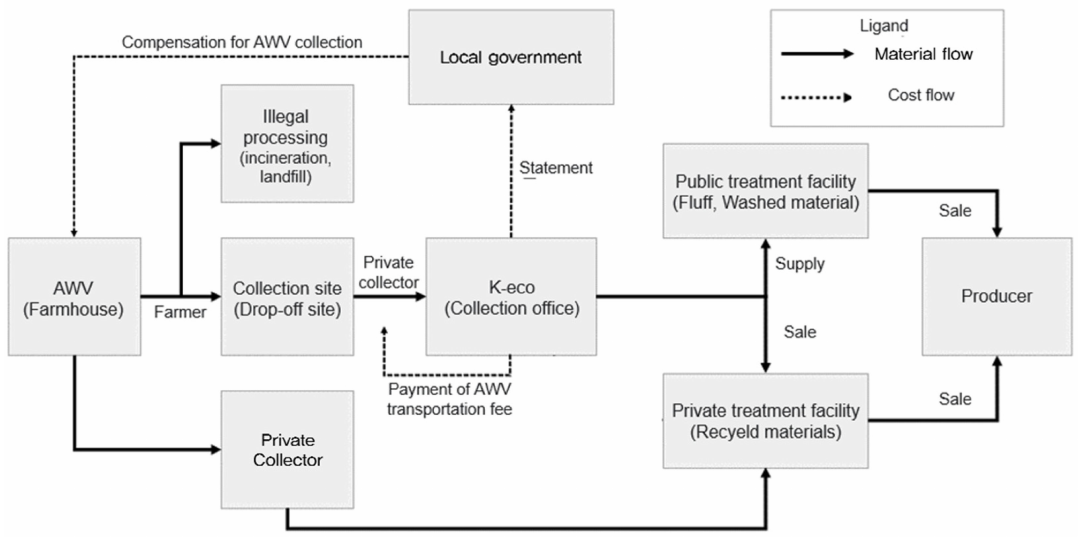
Figure 1. Schemes of AWV management in Korea